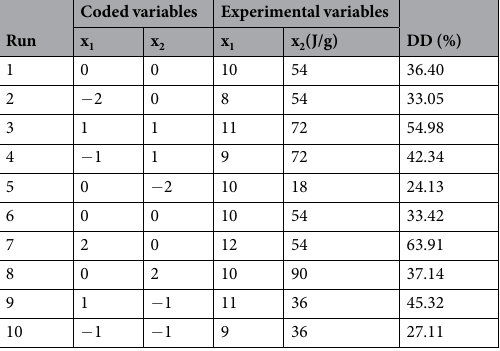
Table 1. Experiment design matrix for combined Alkaline microwaving pretreatment.